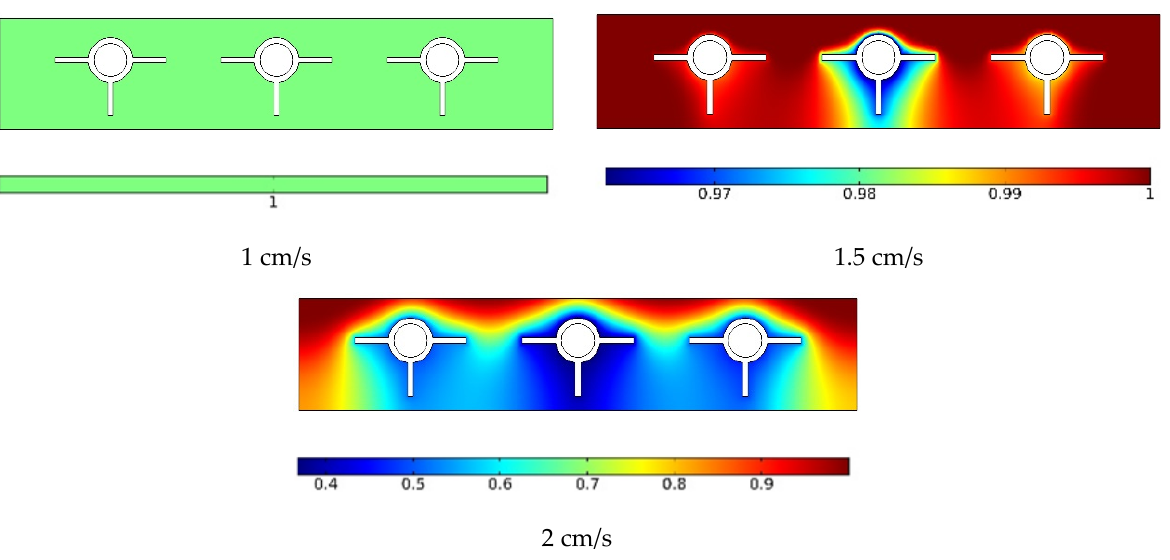
Figure 9. The output temperature at three velocities.